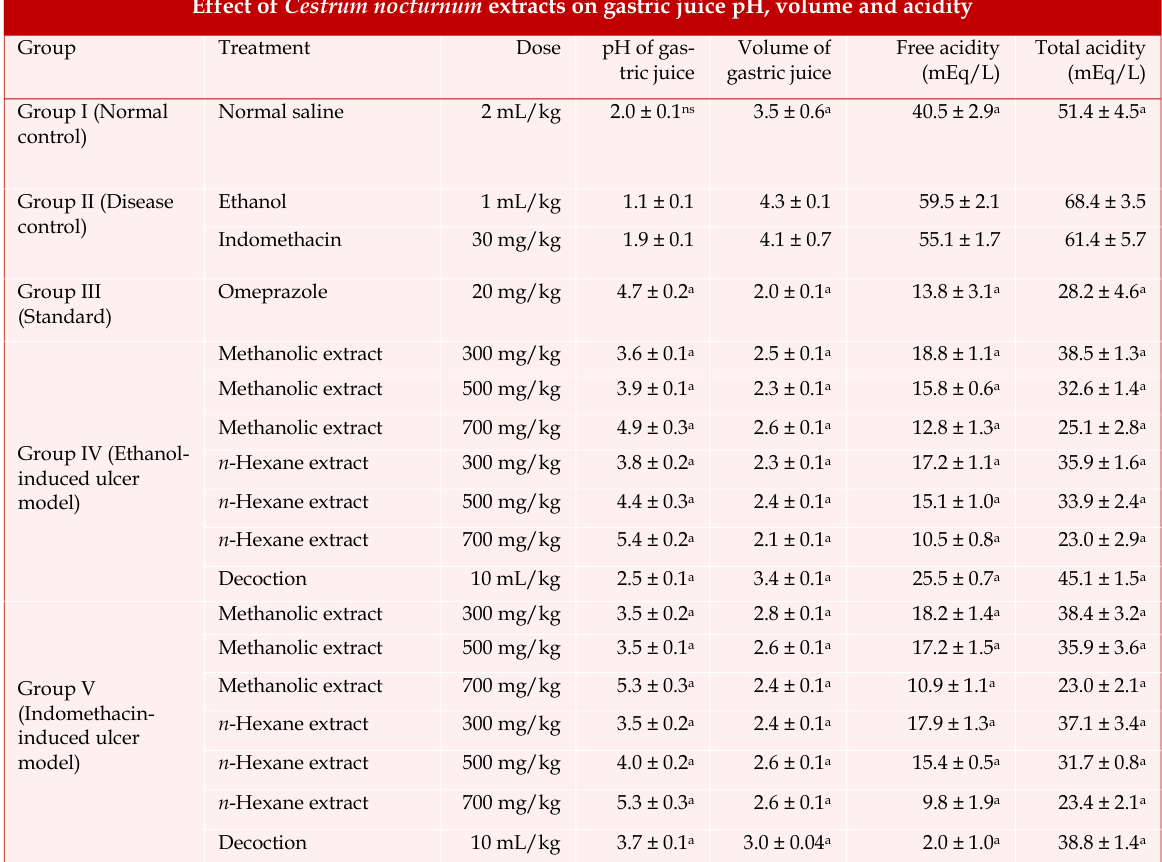
Effect of Cestrum nocturnum extracts on gastric juice pH, volume and